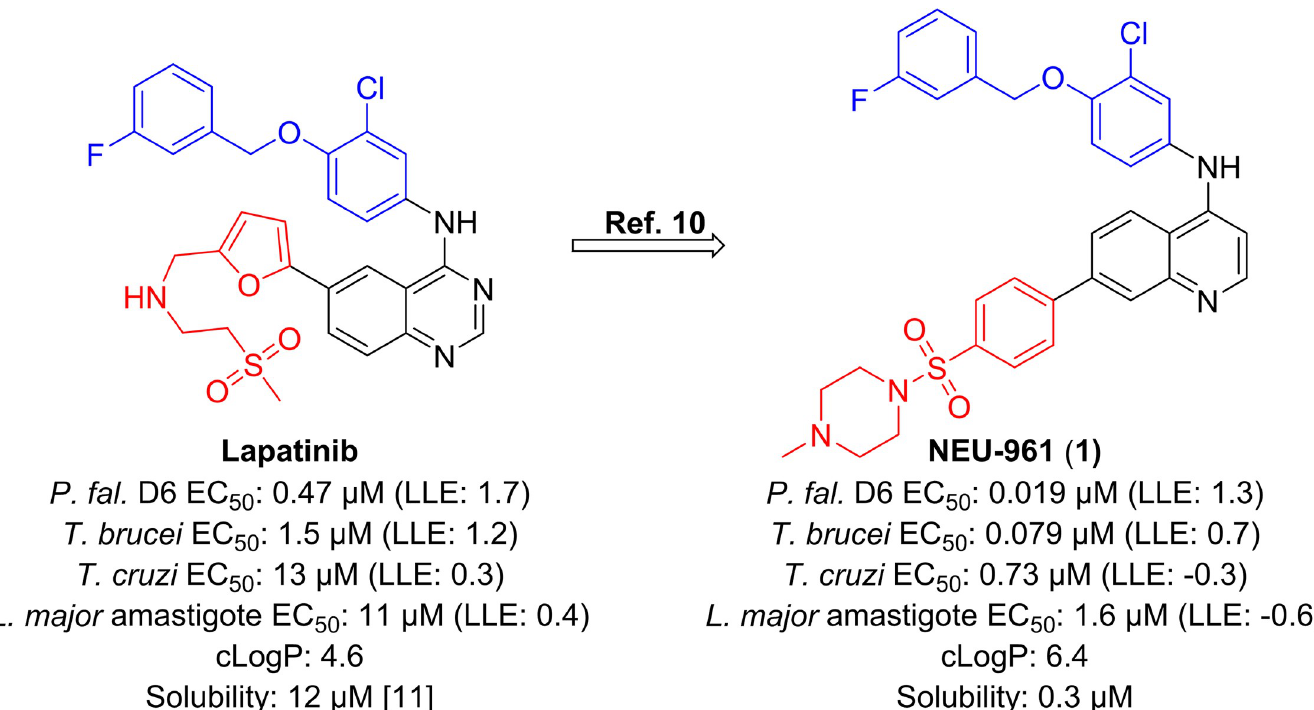
Fig 1. Project progression has led to the identification of potent inhibitors of P . falciparum , T . b . brucei , T . cruzi , and L . major through variations of the head region (shown in blue) and the linker/tail region (shown in red) from lapatinib [12] to compounds typified by 1. Desired ranges for physicochemical properties: cLogP: � 3, lipophilic ligand efficiency (LLE = pEC 50 —cLogP): � 4 [13], aqueous solubility: > 10 μ M.